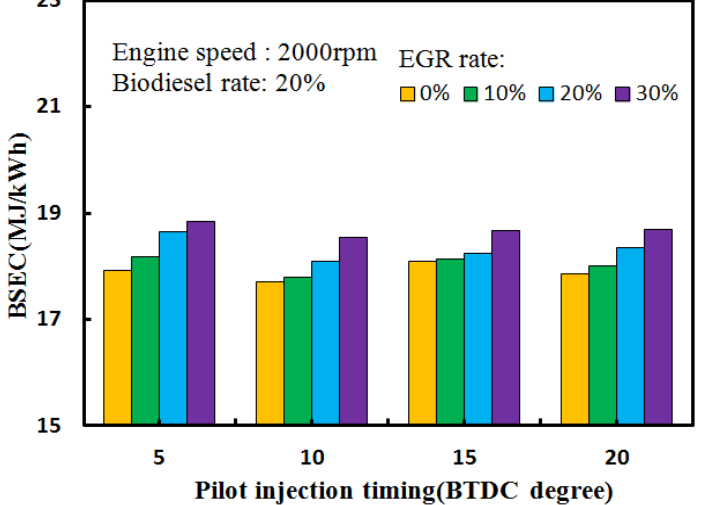
Figure 7. Effects of EGR ratio and pilot injection timing on the